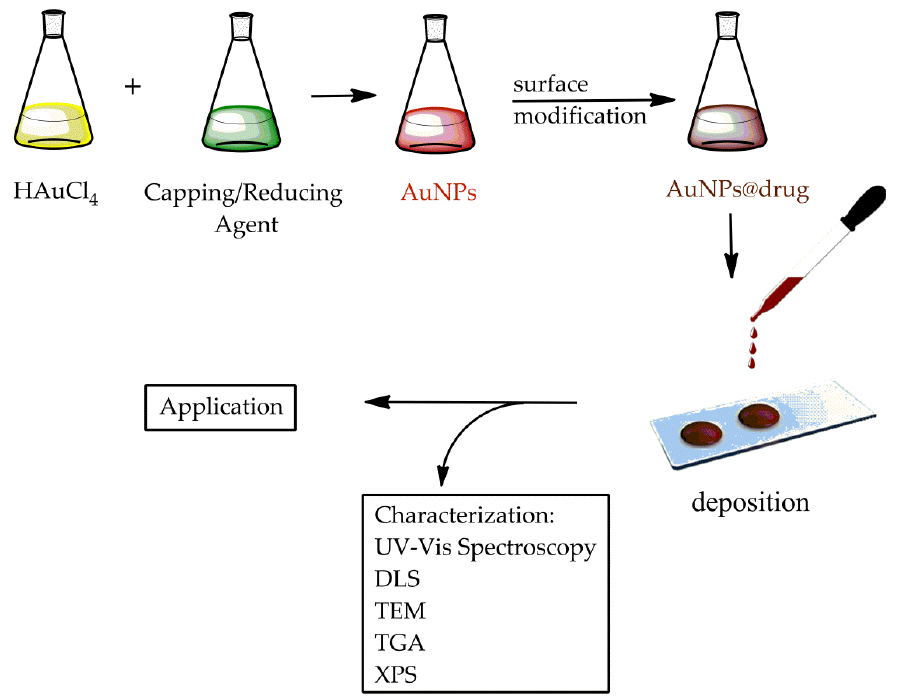
Figure 1. Scheme of the synthesis, characterization, and application of AuNPs.